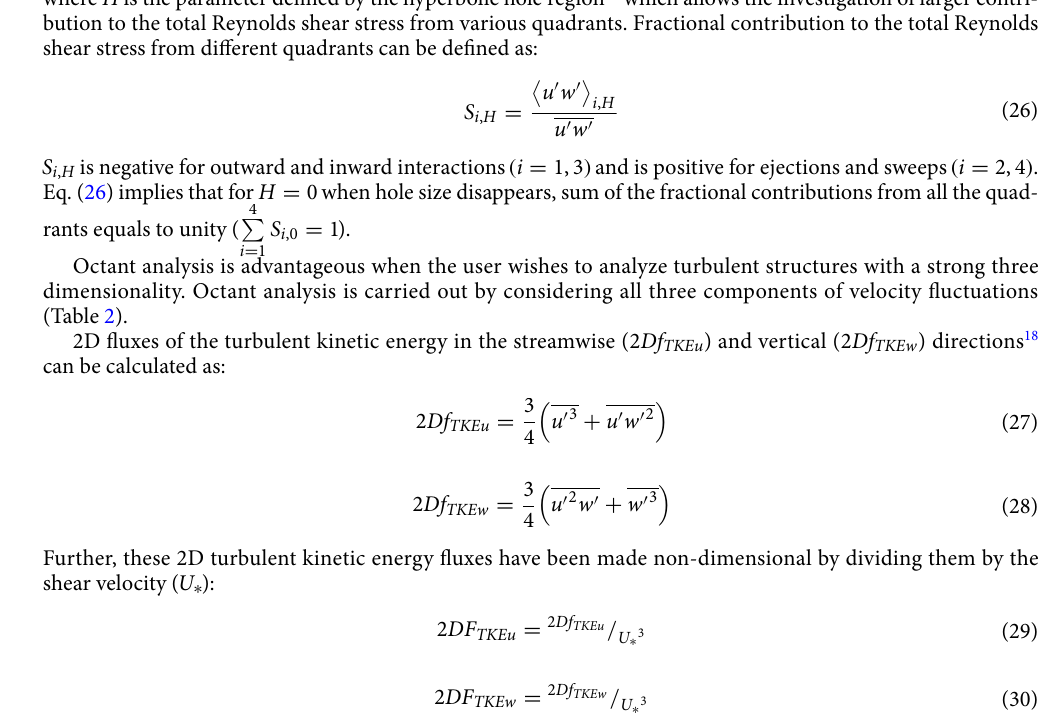
(Table 2). 2D fluxes of the turbulent kinetic energy in the streamwise ( 2 Df TKEu ) and vertical ( 2 Df TKEw ) directions 18